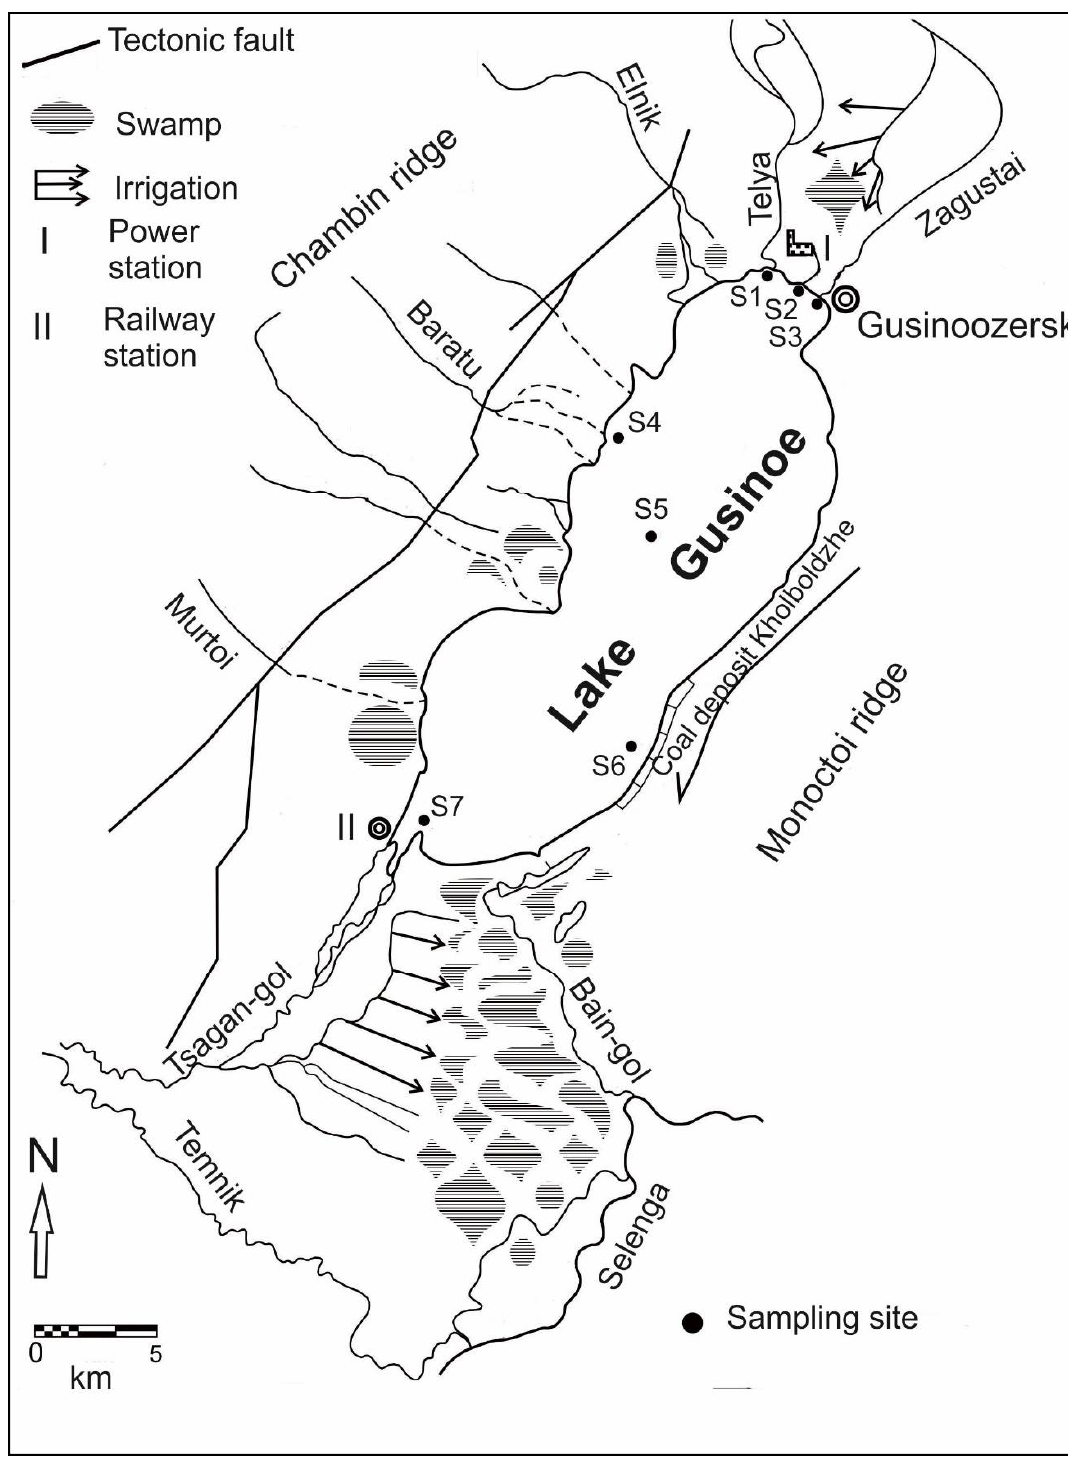
Figure 1. Sampling site at Lake Gusinoe.